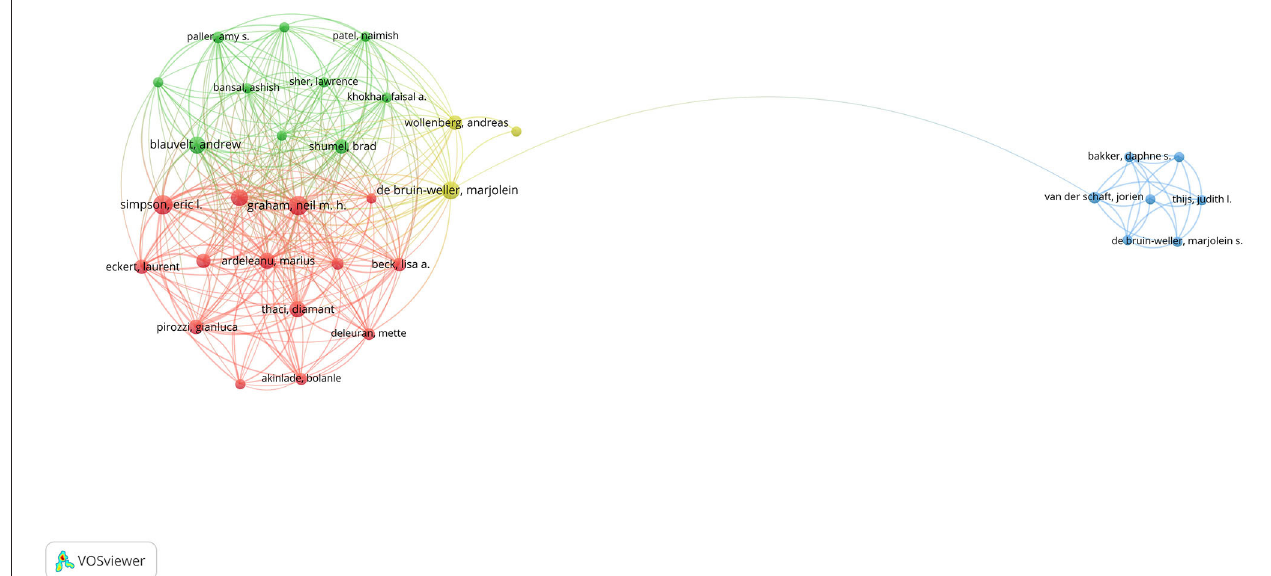
FIGURE 5 | The collaborative network of authors.